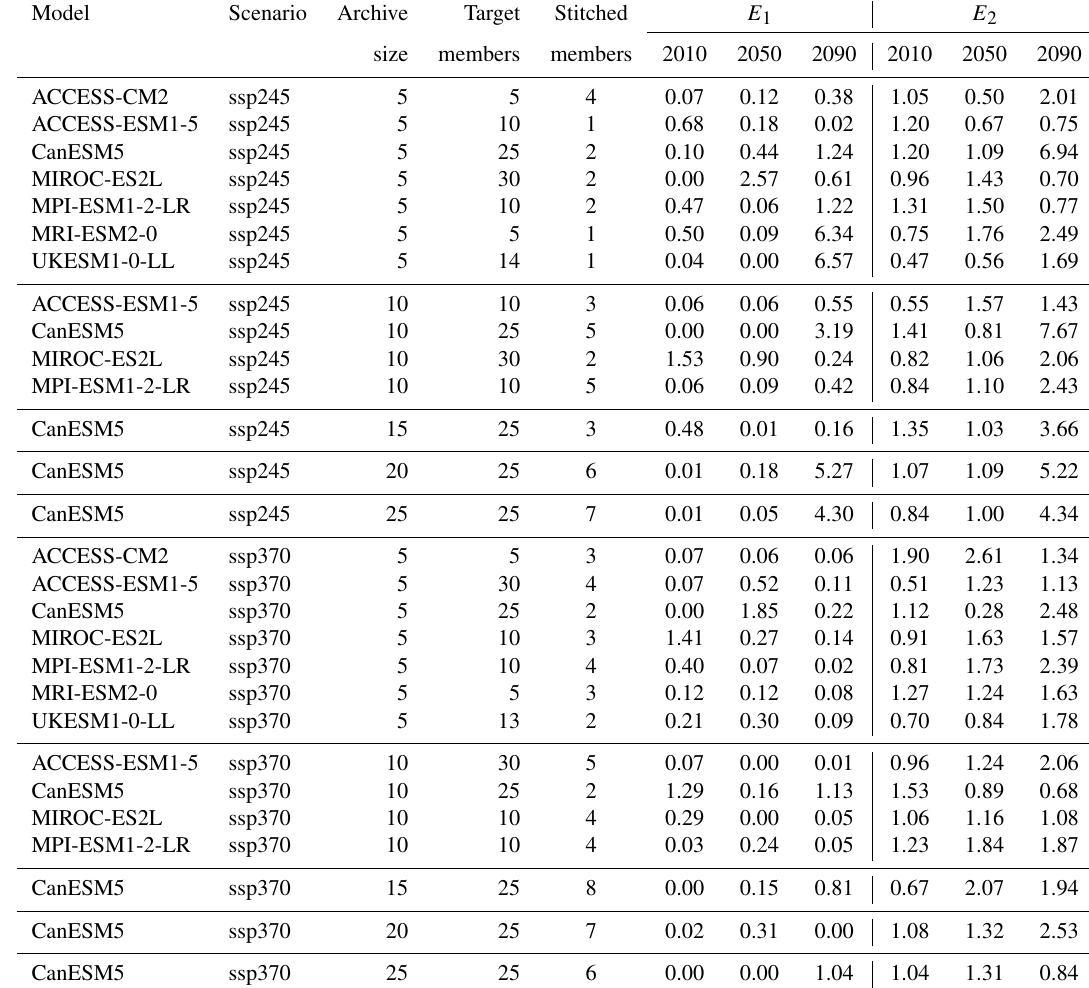
Table F1. The two components of the E r metric, E 1 and E 2 , computed for several experiments across ESMs, scenarios, and number of available archive trajectories from which to create the stitched ensembles. Numbers in columns 4 through 9 represent fractions of the target ensemble standard deviation (see Eq.